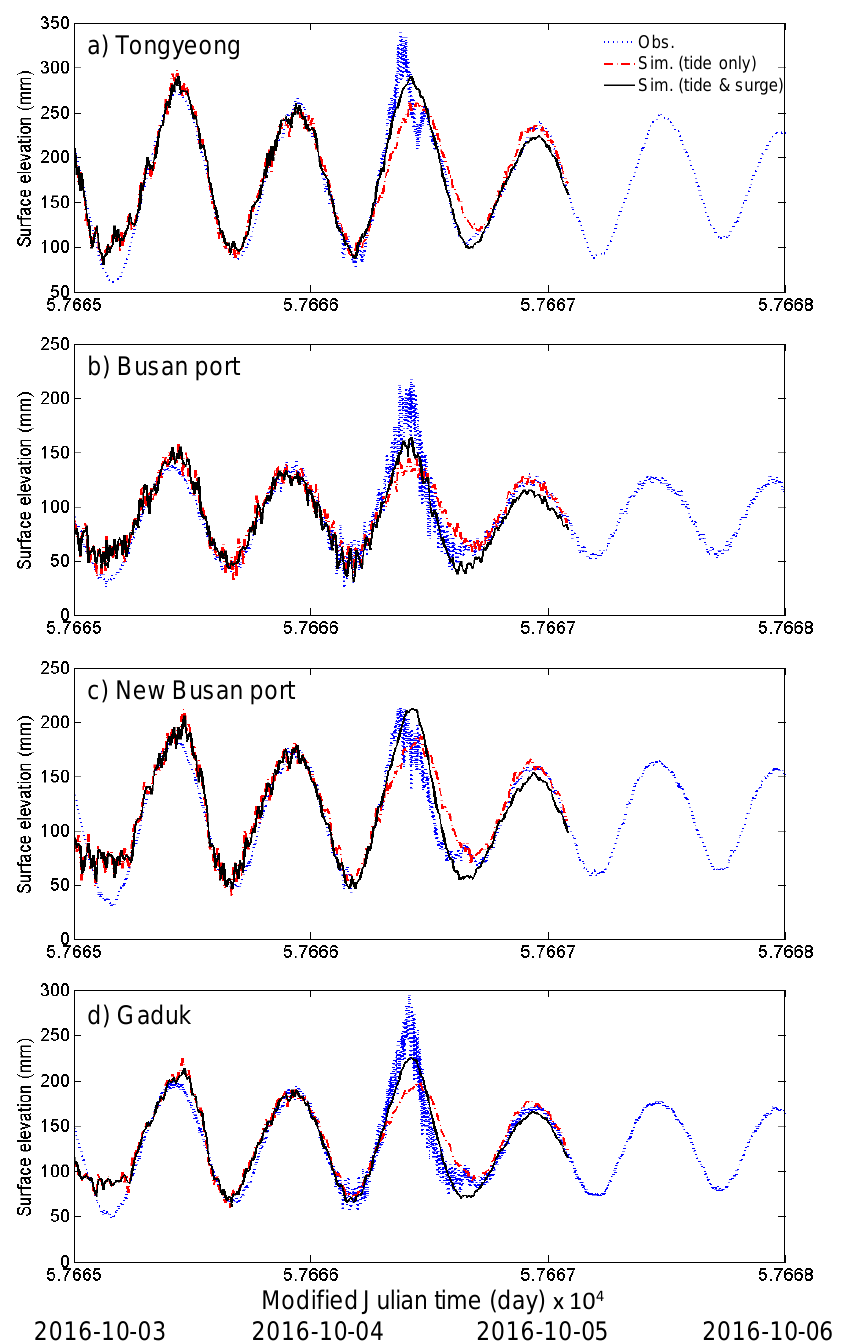
Figure 8. Verification of typhoon-induced surge by using FVCOM: ( a ) Tongyeong; ( b ) Busan port; ( c ) New Busan port; ( d ) Gaduk.